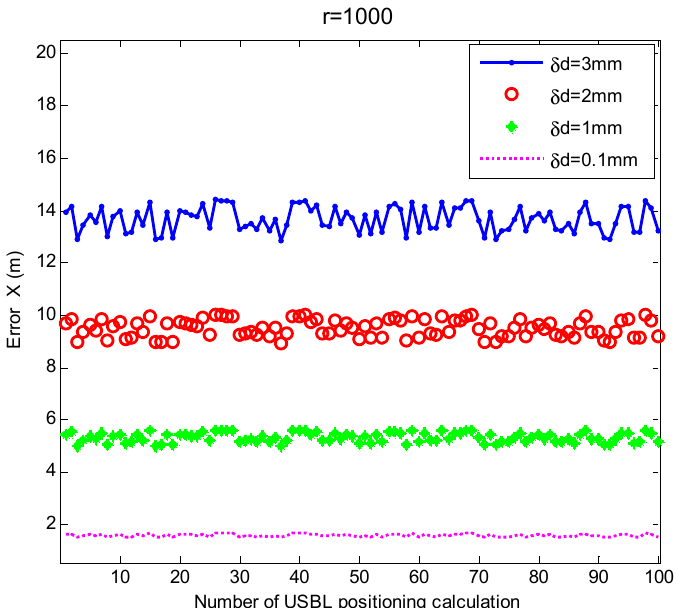
Figure 13. Schematic diagram of the influence of array element spacing error on positioning accuracy (based on the slant range and azimuth method).